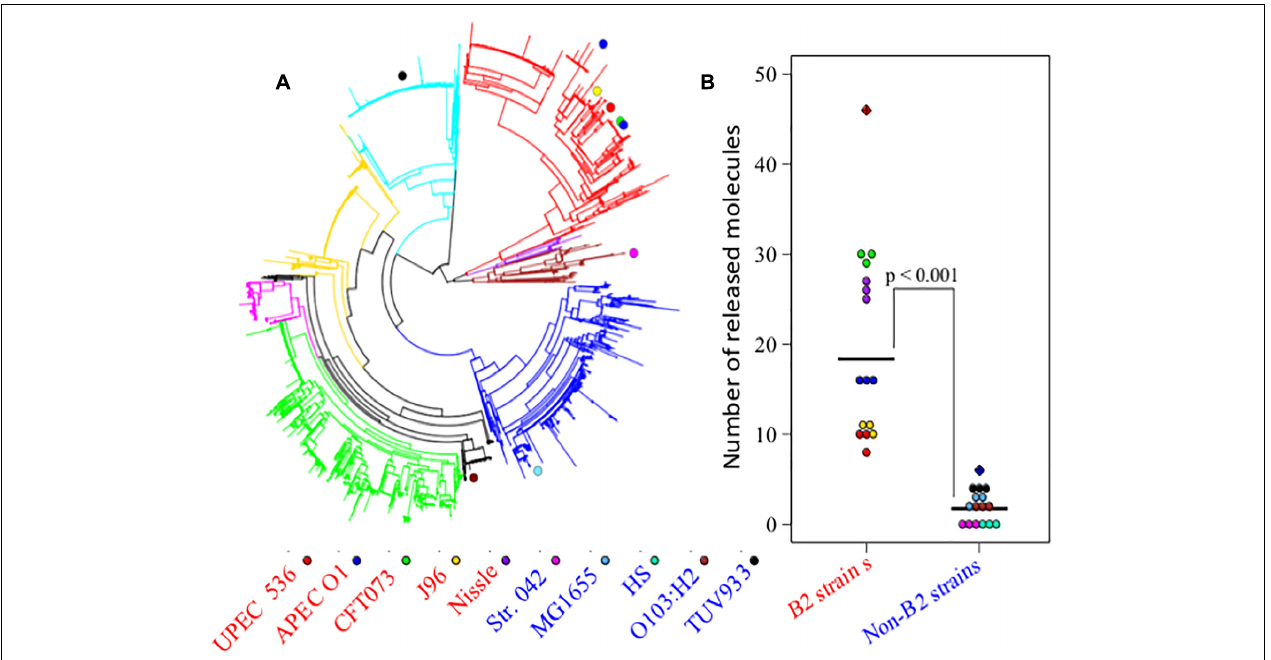
FIGURE 1 | (A) Escherichia coli phylogenetic distance of E. coli strains used in Study 1 ( E. coli B2 and other phylotypes study) with each strain represented by a colored circle – notice the tight grouping of the B2 strains in the upper right segment of the circle. (B) Numbers of released metabolites by phylogroup B2 strains that were not found in non-B2 strains and vice versa following the same strain labeling as for (A) . The results show that B2 strains possess a more diverse arsenal of small molecules than the non-B2 strains measured in this study. In total, phylogroup B2 strains biosynthesise 46 metabolites that are not produced by non-B2 strains (red hatched diamond), whereas non-B2 strains produce only 6 metabolites that could not be detected in the B2 group (blue hatched